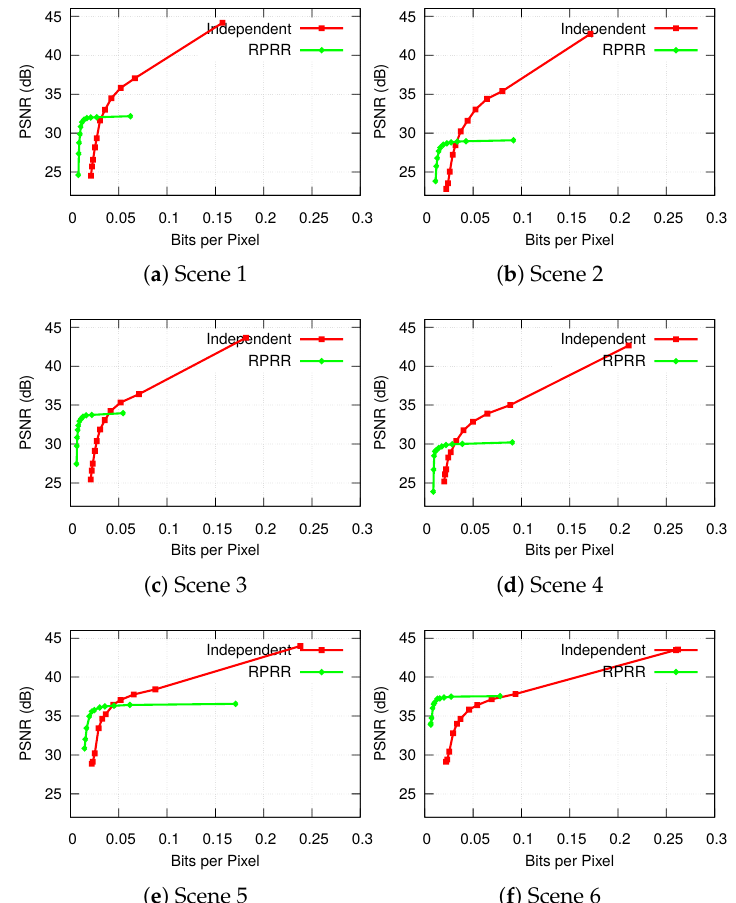
Figure 13. Comparisons of PSNR (dB) achieved by compressing the images at various levels by using the RPRR framework against transmitting them